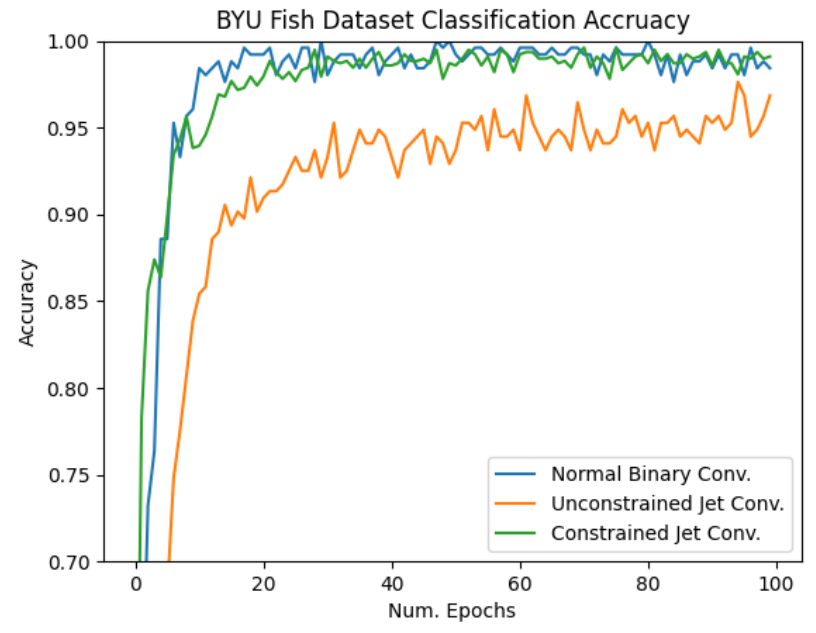
Figure 9. Classification accuracy on the BYU Fish dataset.